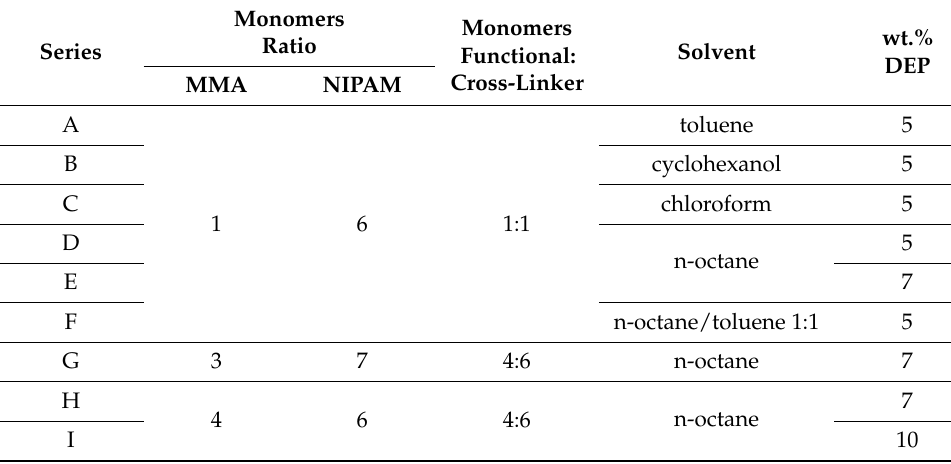
Table 1. Composition of the polymerization